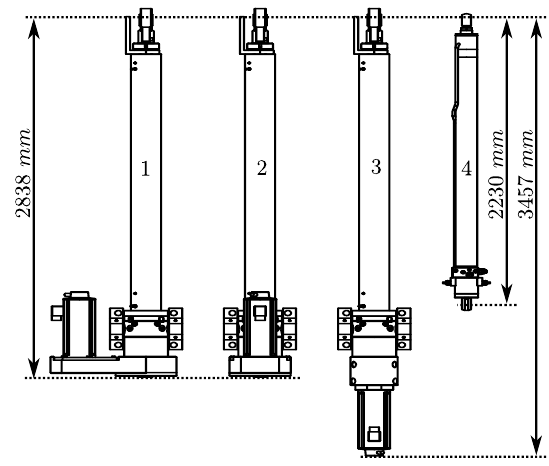
Figure 15: 1-2: motor attachment via timing belt side drive. 3: motor attachment via flange and coupling. 4: existing hydraulic cylinder.